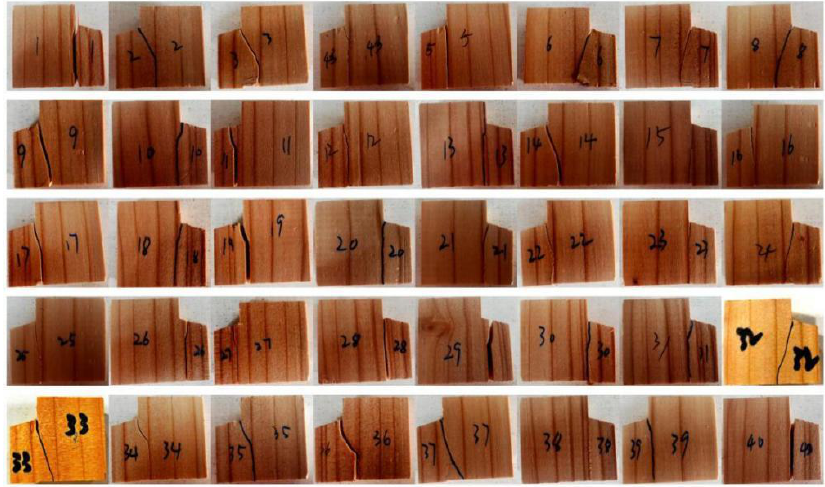
Figure 2. Failure mode of the shear failure of 40 samples.